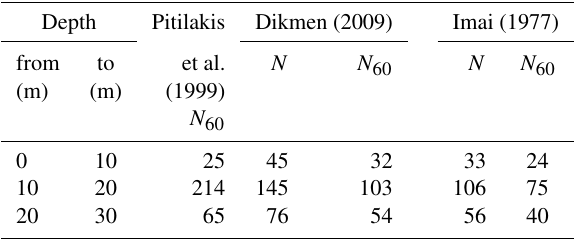
Table 3. Parameters for estimating N 60